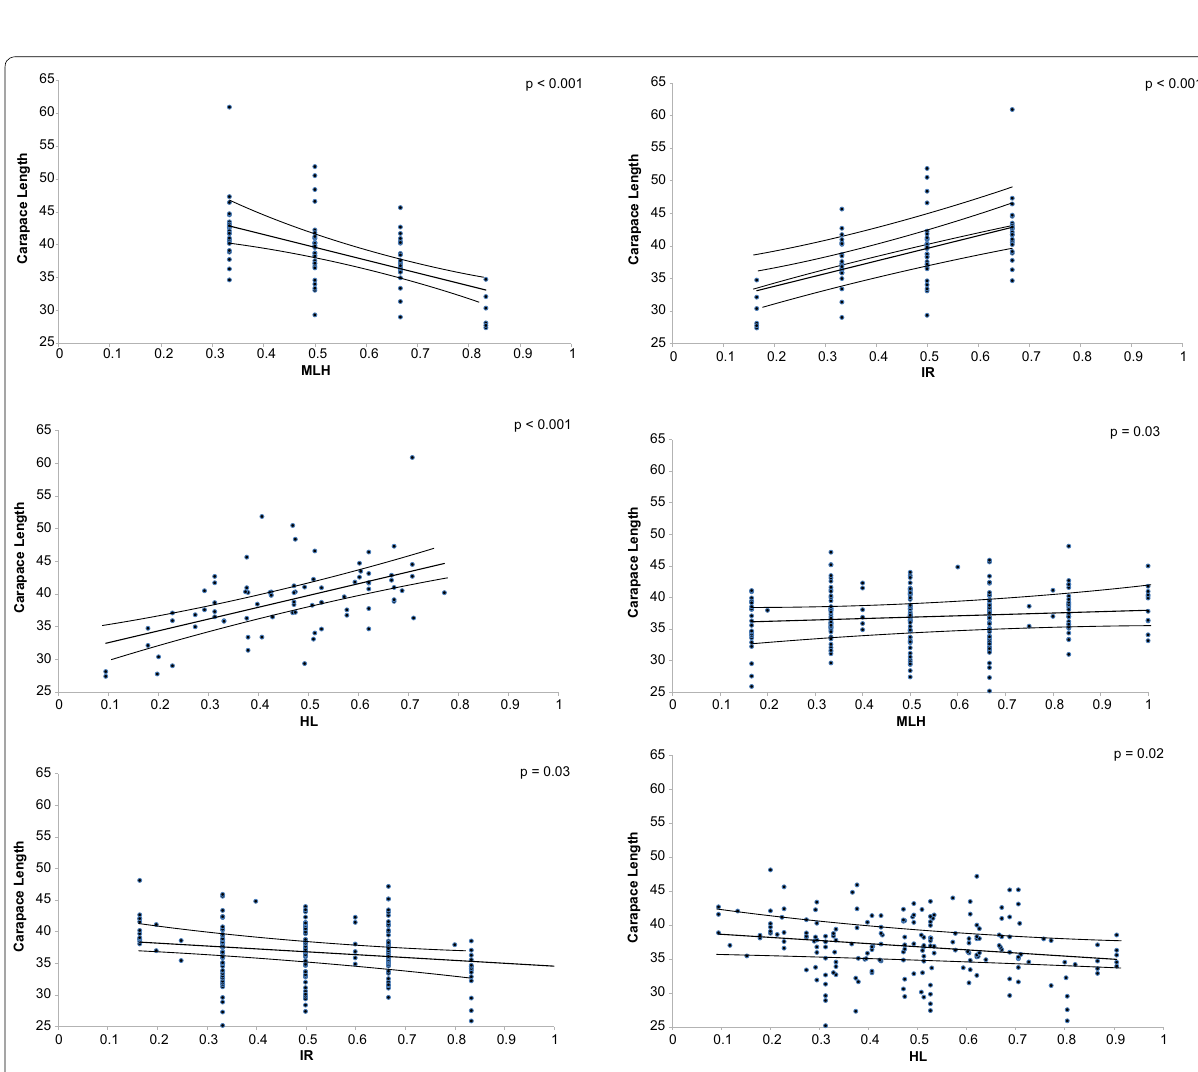
Fig. 4 Regression plots of the three different measures of heterozygosity against the carapace length in male individuals ( a MLH; b IR; c HL), and female individuals ( d MLH; e IR; f HL). Dashed lines represent confidence intervals (95%)